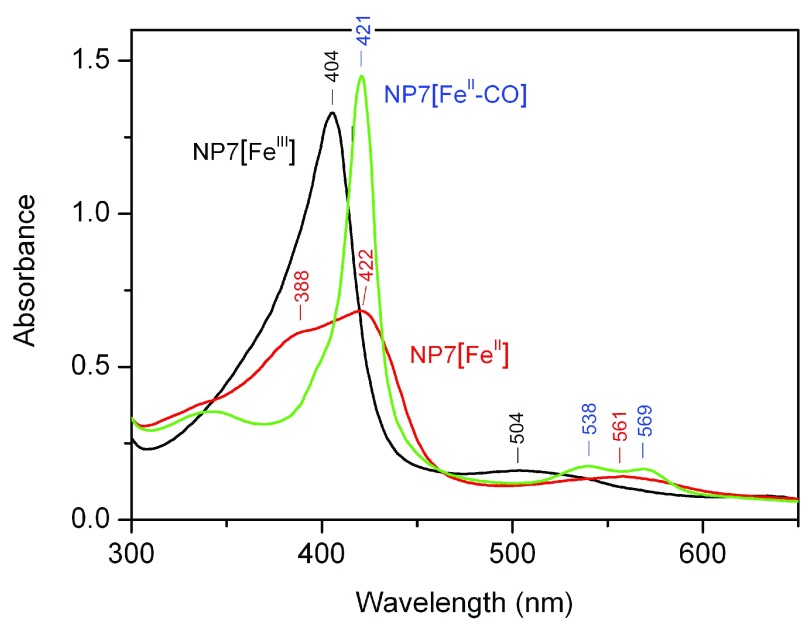
Absorption spectra of ferric and ferrous NP7 at pH 7.5.
Black: NP7[Fe
III];
red: NP7[Fe
II];
blue: NP7[Fe
II–CO].